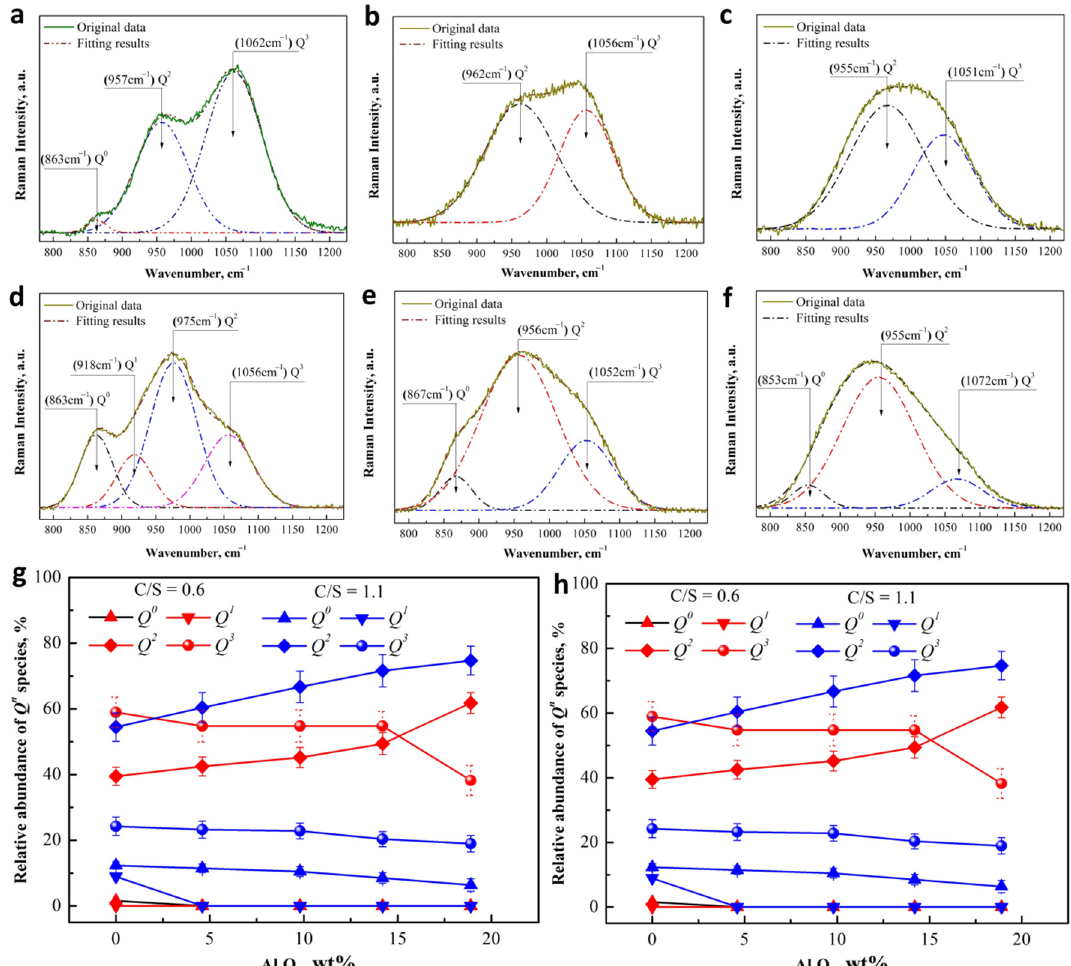
Figure 4. Deconvolution of the Raman spectra for CaO − SiO 2 − Al 2 O 3 slag at room temperature with 0 Al 2 O 3 and 0.6 of basicity ( a ); 9.93 wt% Al 2 O 3 and 0.6 of basicity ( b ); 18.97 wt% Al 2 O 3 and 0.6 of basicity ( c ); 0 Al 2 O 3 and 1.1 of basicity ( d ); 9.4 wt% Al 2 O 3 and 1.1 of basicity ( e ); 18.9 wt% Al 2 O 3 and 1.1 of basicity ( f ), Distribution of Q n speciation ( g ), and NBO/T ( h ) as a function of basicity